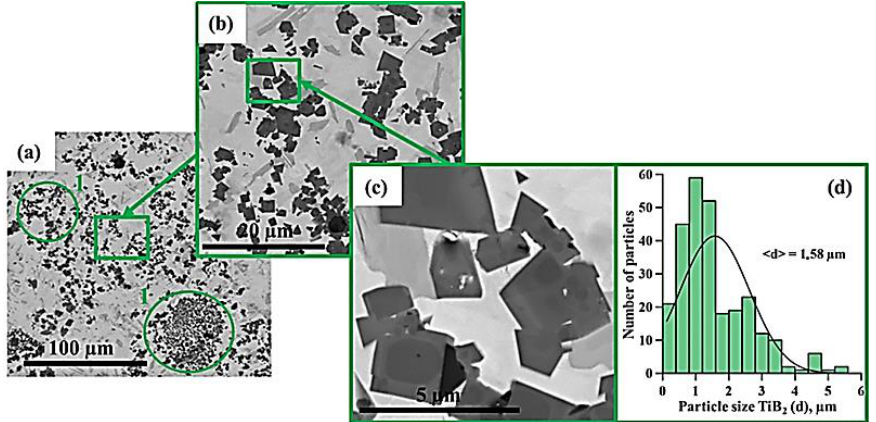
Figure 7. SEM image of the structure of a composite fabricated by direct laser deposition from the Inconel 625 + 30 wt% NiTi – TiB 2 powder mixture ( a – c ), histogram of the distribution of ceramic inclusions by size ( d ).